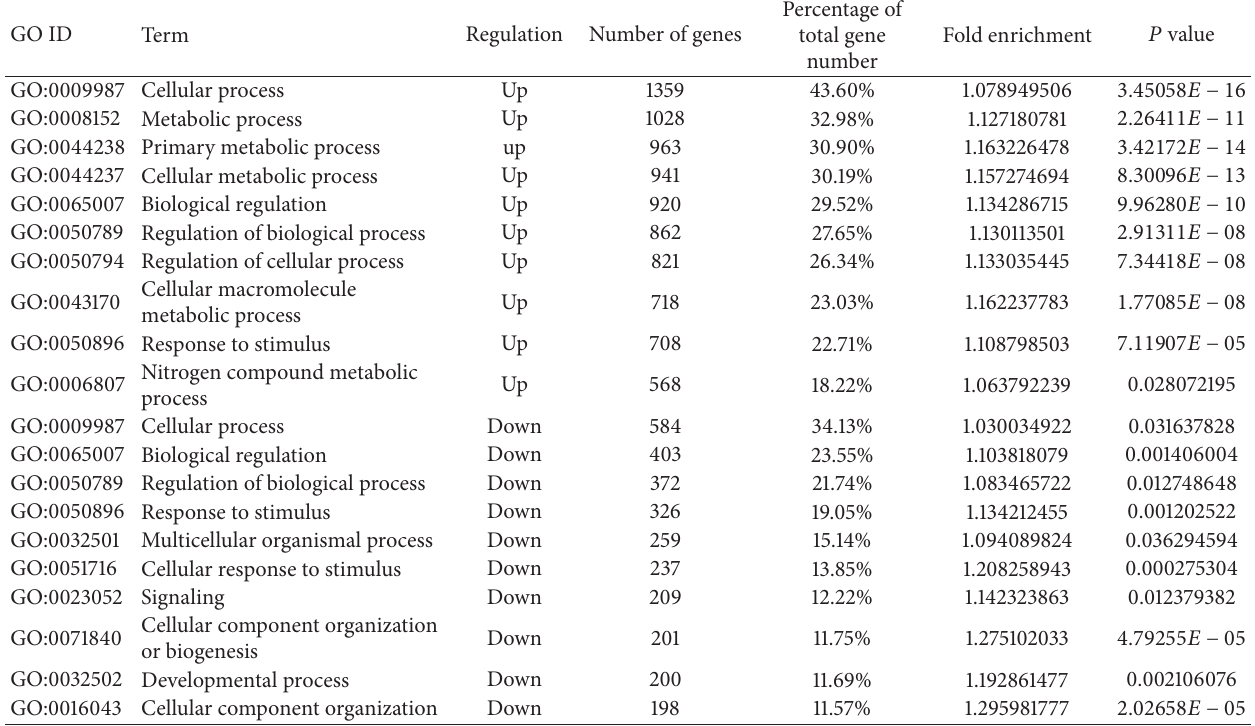
Table 3: GO analysis of RA SMSCs with different biological processes related to differentially expressed genes.